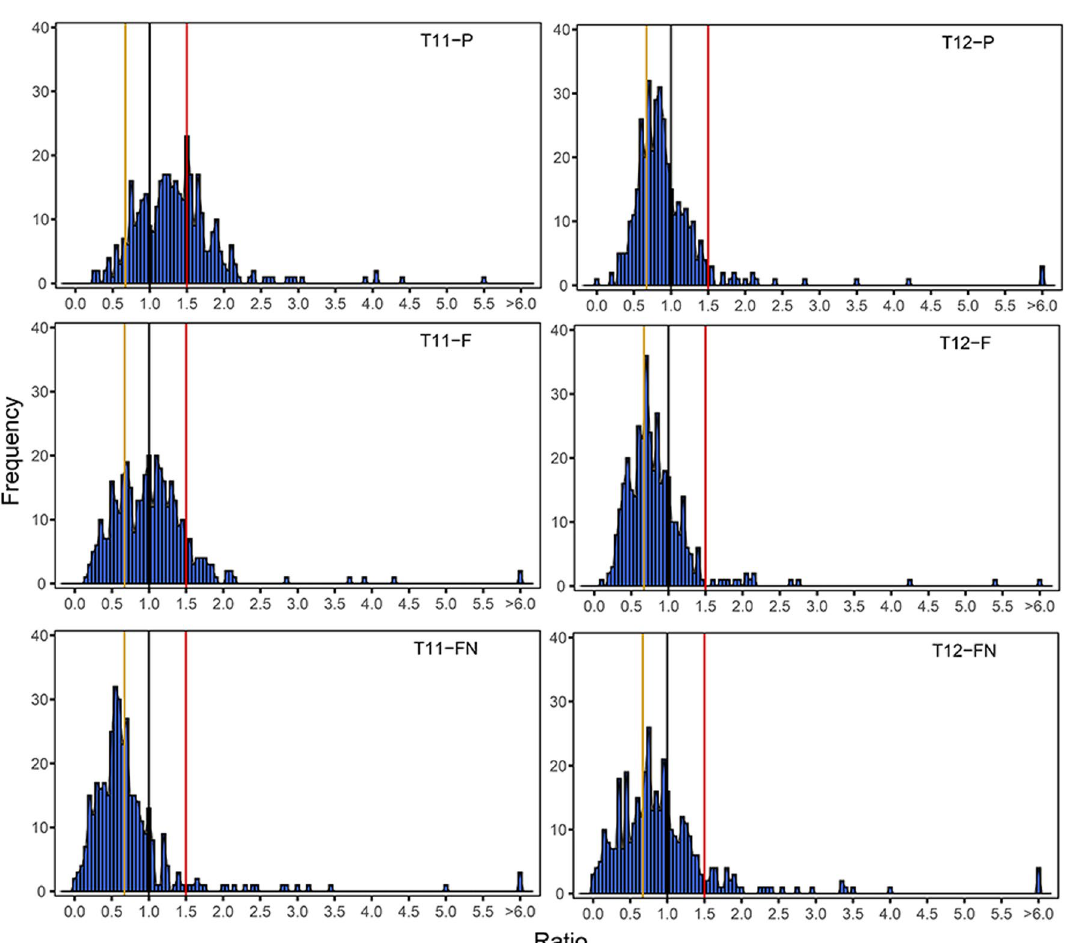
Fig. 6 Ratio distributions of gene expression of for the functional class of ribosomal structural genes in T11 and T12. The ratios were plotted with bins of 0.05 increments. X-axis represents the ratio bin of fold-change in gene expression levels and Y-axis represents the gene frequency per